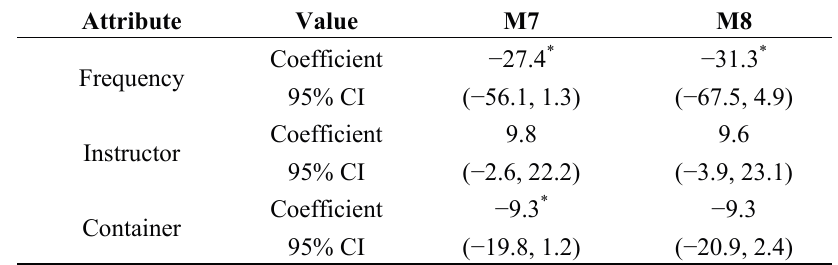
Table 5. Marginal willingness to accept (MWTA) compensation estimates for age group above 60 in Chinese Yuan Renminbi